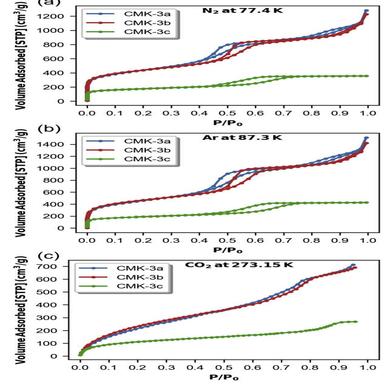
Pore size distributions for (a) CMK-3a, (b) CMK-3b, and (c) CMK-3c samples using a cylindrical pore model kernel (left column), and slit pore model for micropores and cylindrical pore model for mesopores (right column). (A colour version of this figure can be viewed online.)